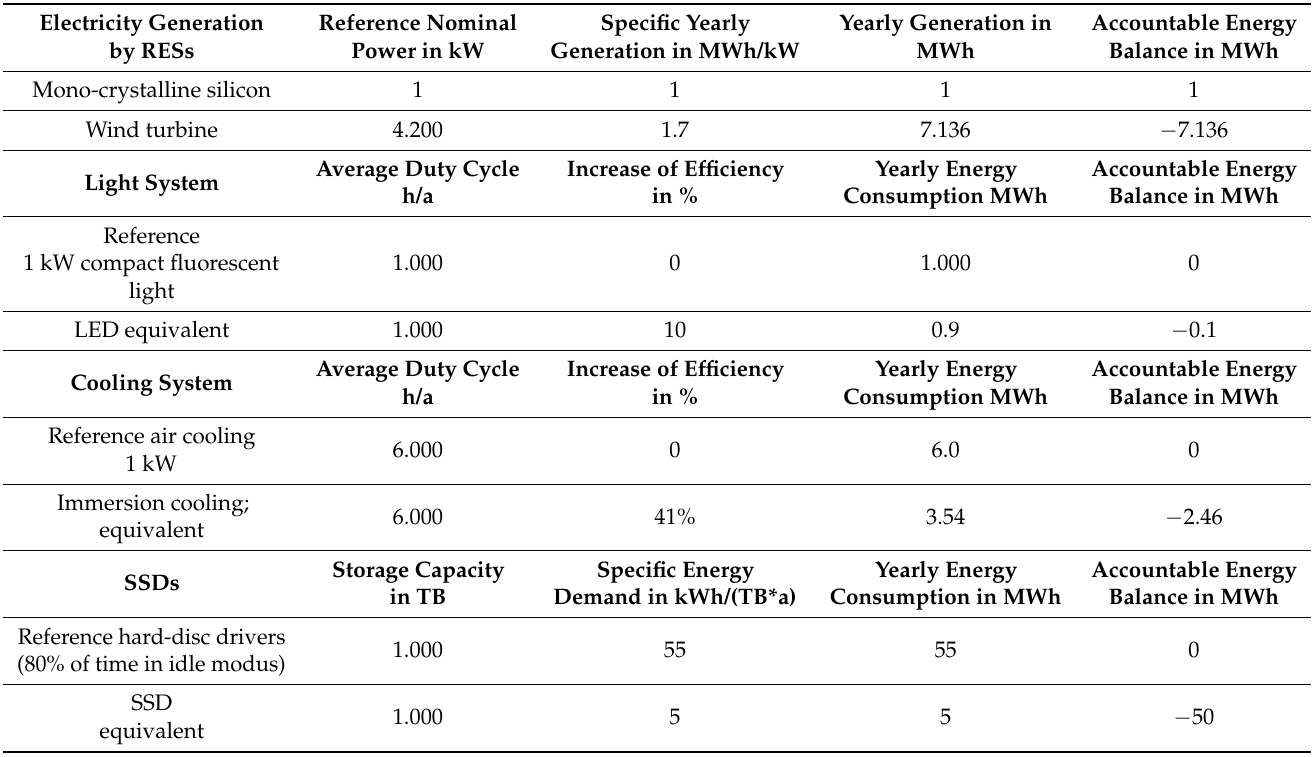
Table 5. Energetic indicators of the planning measurements.